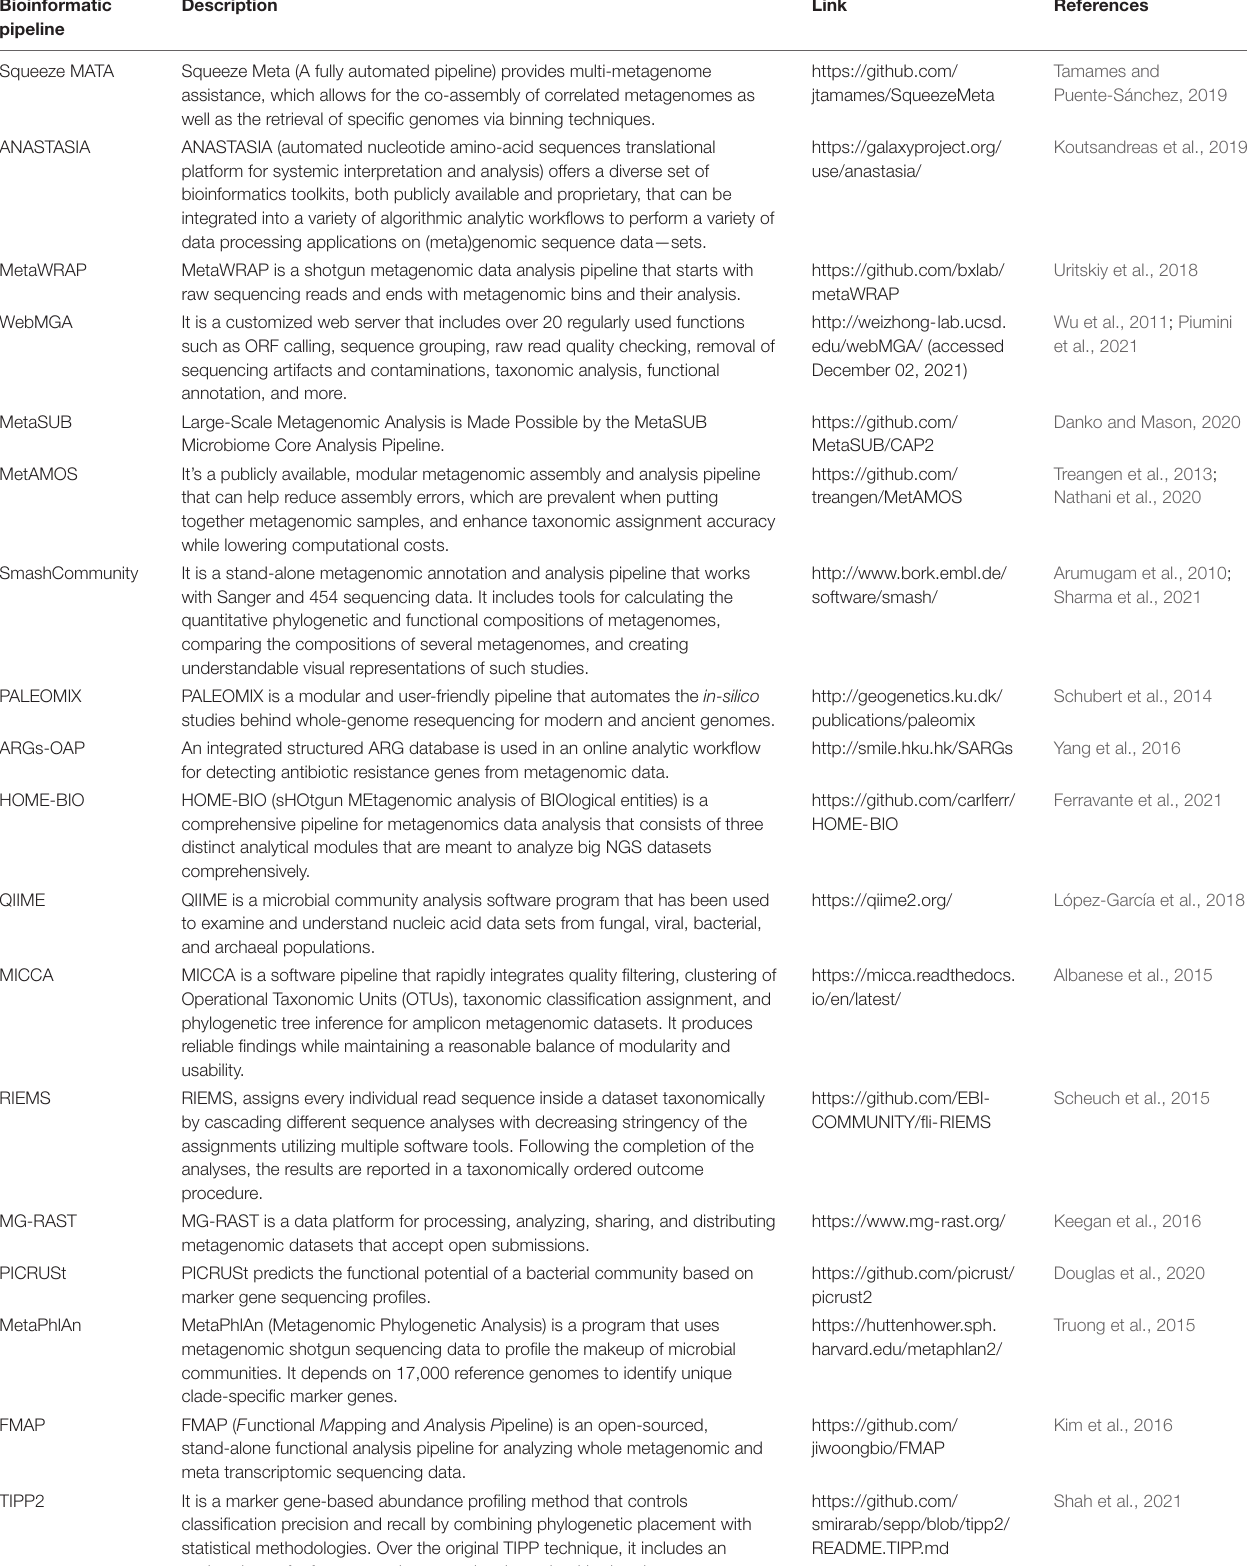
TABLE 2 | Bioinformatic pipelines for metagenomic data